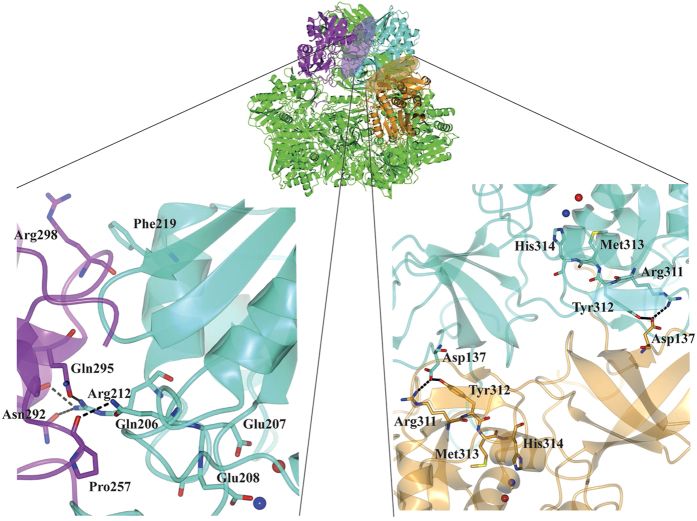
M1 site affects the stability of the PfTET3 oligomeric and dimeric interfaces.On the top, the purple ellipse in the dodecamer highlights the oligomeric interface (formed by subunits purple and cyan) and the golden ellipse highlights the dimeric interface (formed by subunits gold and cyan). Left panel, inset of PfTET3 oligomeric interface (purple and cyan subunits). M1 and M2 sites are represented as a blue and a red sphere, respectively. The M1 coordinating residue, Glu208, lay on a loop that hosts Gln206, Arg212 (cyan). These residues are involved in H-bonding (represented by dashed lines) with Pro257, Asn292 and Gln295 of the adjacent subunit (purple). Additionally, Phe219 establishes π-stacking interactions with Arg298 of the adjacent subunit. Noteworthy, such interface is repeated 12 times in the dodecamer. Right panel, inset of PfTET3 dimeric interface (golden and cyan subunits). His314 coordinating the M1 site is close to the PfTET3 dimeric interface. In particular, Arg311 and Tyr312 are involved in salt bridges (represented with dashed lines) with Asp137 of the adjacent subunit. Noteworthy, each dimeric interface contain two copies of such interactions due to the 2-fold symmetry of the dimeric interface.